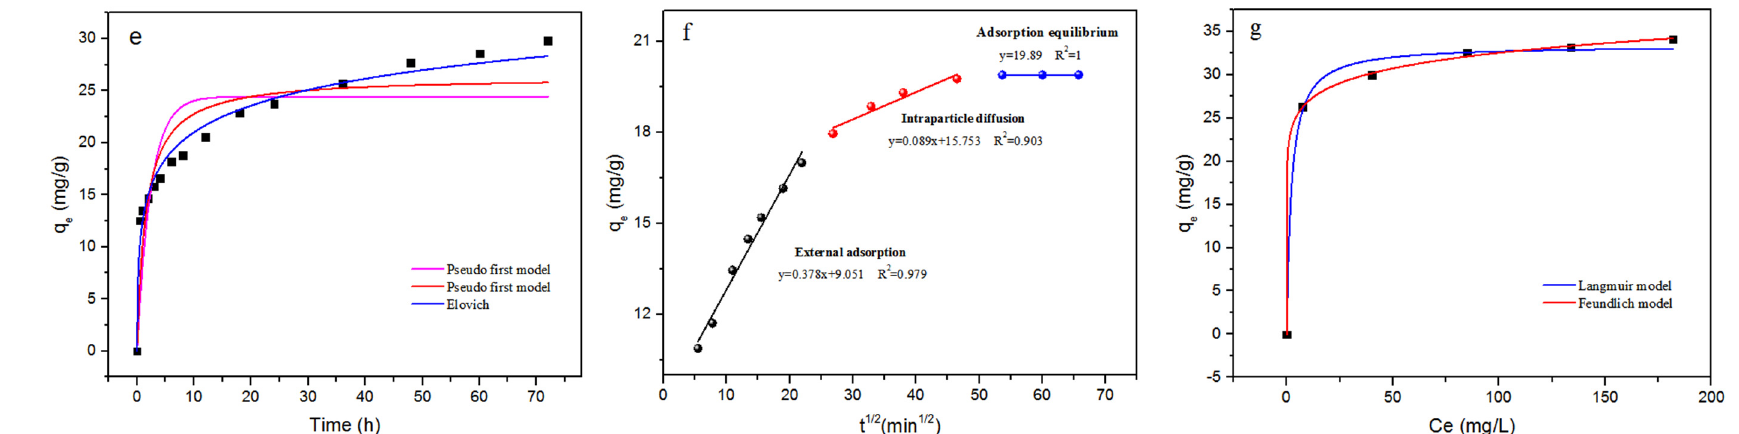
Figure 4. The effect of dosage of FeCl 3 @BC on Cr(VI) elimination efficiency ( a ); influence of initial pH ( b ); removal efficiency of FeCl 3 @BC at different initial concentrations of Cr(VI) ( c ); influence of competing ions ( e ); adsorption kinetics ( d ); intragranular diffusion model (dosage of 5 g/L) ( f ); and adsorption isotherm ( g ).